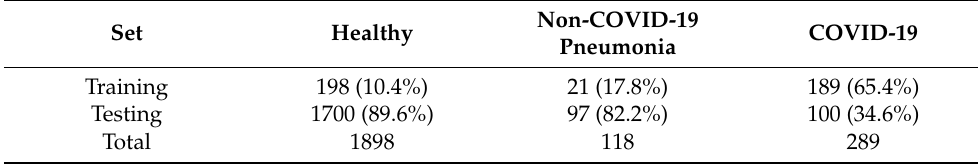
Table 5. E*HealthLine dataset training and testing